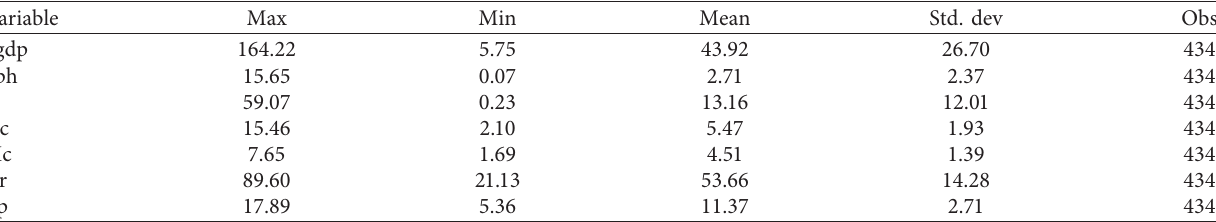
Table 2: Summary statistics of all variables.